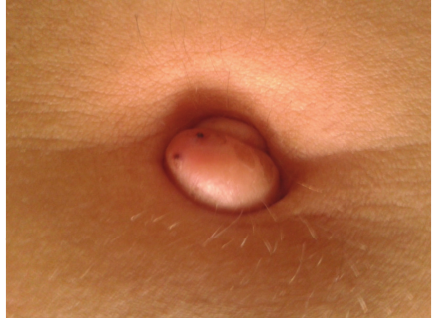
Figure 2: Umbilical